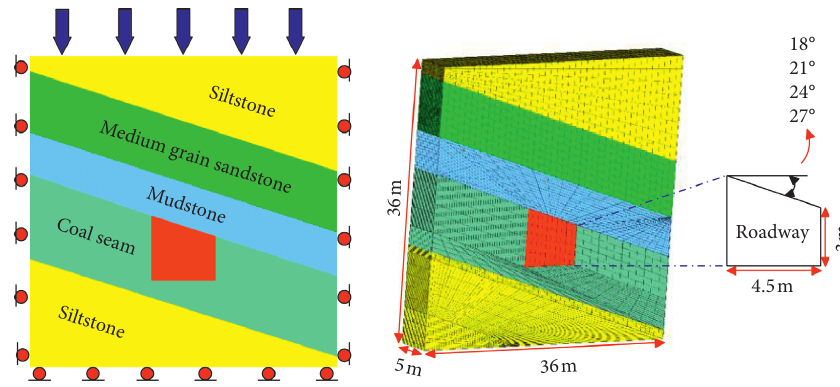
Figure 4: Numerical calculation Table 1: Numerical simulation of physical and mechanical parameters of coal and rock.